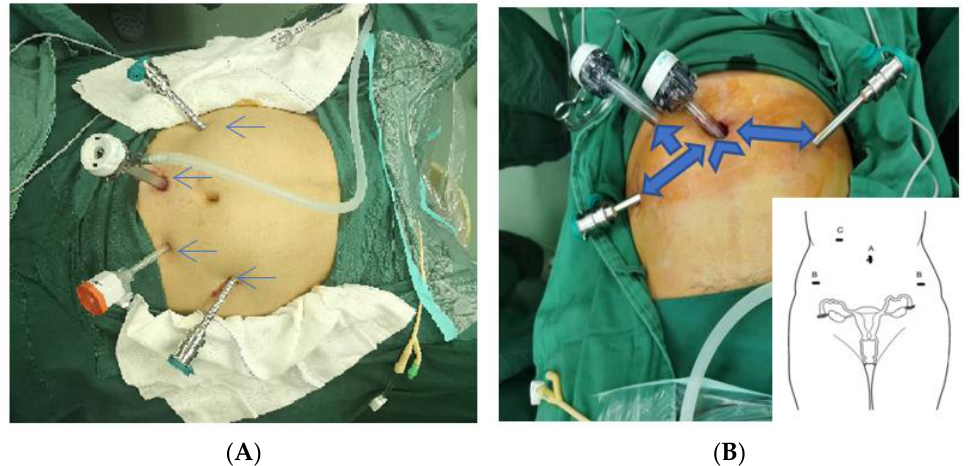
Figure 1. ( A ) The location of the puncture hole in traditional robot-assisted surgery: the camera hole is located at 2–4 cm above the umbilicus (the left side can be opened by 1–2 cm to avoid damage to the retroperitoneal large blood vessels), and the No. 1 arm hole is located at 8–10 cm from the right side of the camera arm, forming an angle of 0–30° with the camera arm (foot side); the No. 2 arm hole is located at 8–10 cm to the left of the camera arm, at an angle of 0–30° with the camera arm (foot side), and the auxiliary hole is located at 5–8 cm above the midpoint of the line connecting the camera hole and No. 1 arm hole. ( B ) Improved puncture hole location for robotic myomectomy: moving the camera hole to the umbilicus follows the principle of Figure 1B, and the puncture positions of other puncture holes follow the principle of Figure 1A.